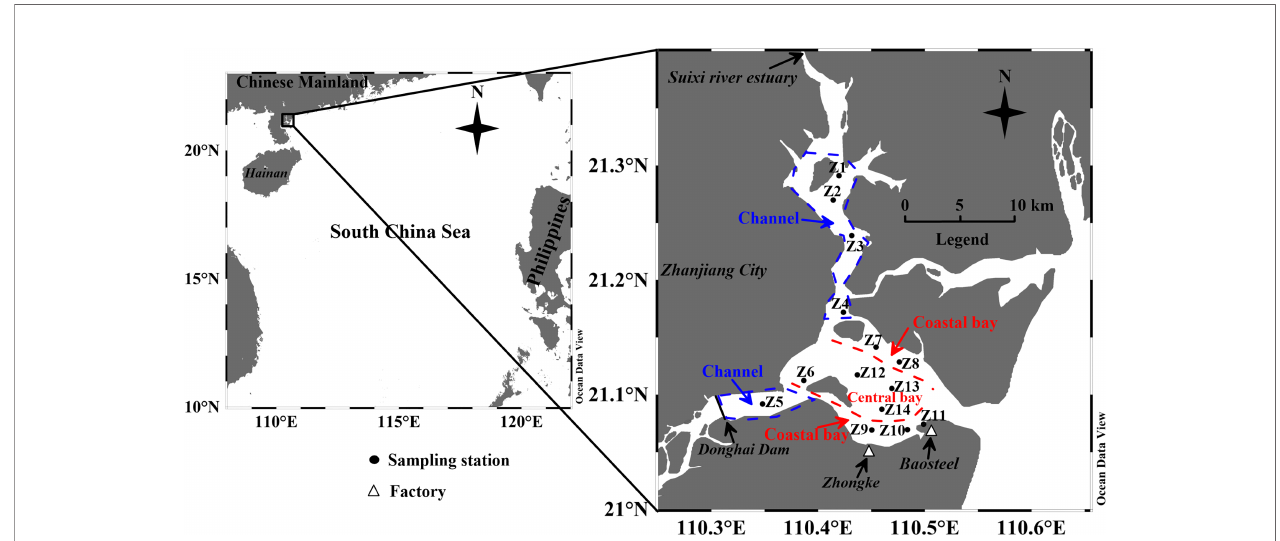
FIGURE 1 | Sampling stations in the Zhanjiang Bay. The Zhanjiang bay is divided into three subregions: channel, coastal bay and central bay. Zhongke: Zhongke (Guangdong) Re fi ning and Chemical Co., Ltd. Baosteel: Baosteel Zhanjiang Iron Steel Co.,